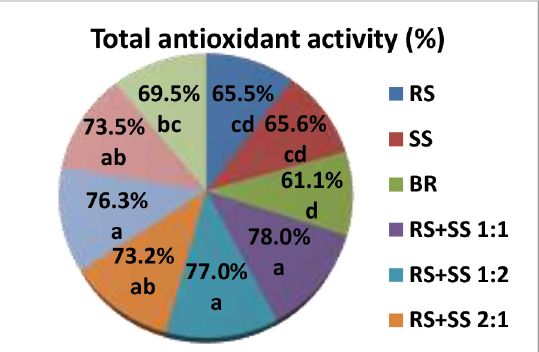
Fig. 3 Crude protein of oyster mushroom ( P. ostreatus ) six different mixtures of SS and BR with rice straw at 1:1, 1:2, and 2:1 ratio